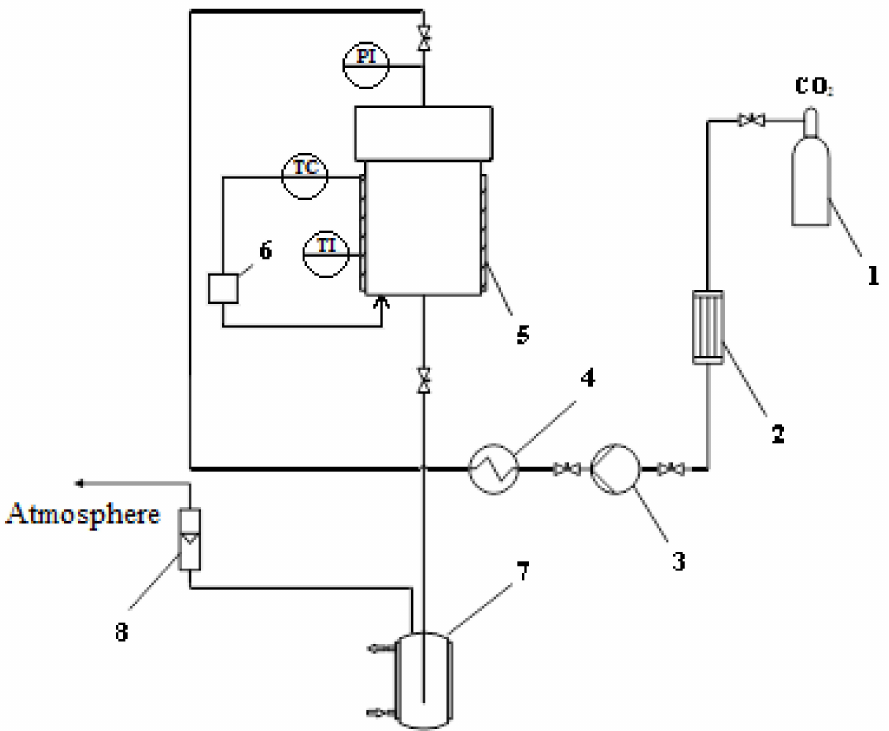
Figure 1. Scheme of a high-pressure reactor for carrying out the supercritical drying process. 1— tank with CO 2 , 2—condenser, 3—piston pump, 4—heater, 5—high-pressure reactor, 6—thermal control system, 7—separator, 8—rotameter, PI—pressure gauge, TC—temperature sensor, TI—temperature sensor.